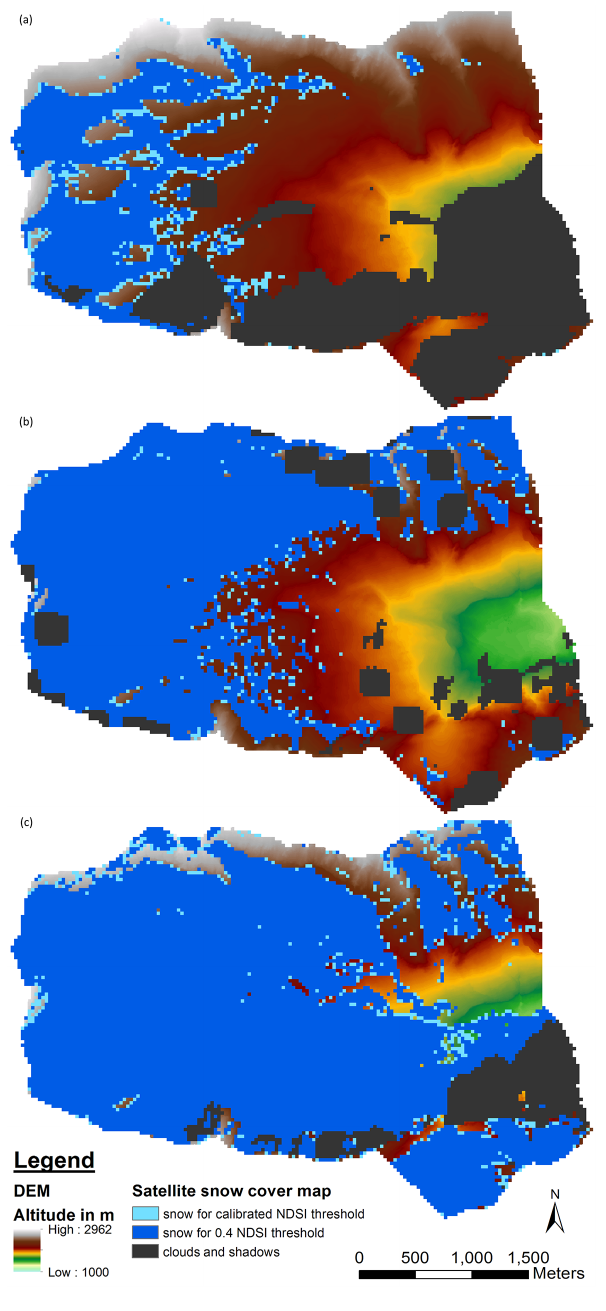
Figure 13. Standard and optimized snow cover maps of the Zugspitzplatt catchment for 17 November 2011 (a) , 1 July 2013 (b) , and 7 April 2014 (c) : snow cover extents using the standard NDSI threshold value of 0.4 are depicted in dark blue, additionally detected snow cover using the SLR calibrated NDSI threshold val- ues of 0.18 (a) , 0.35 (b) , and 0.23 (c) in light blue, and clouds and shadows in dark grey. The snow cover maps are superimposed on the DEM of the investigation area (cf. Fig.